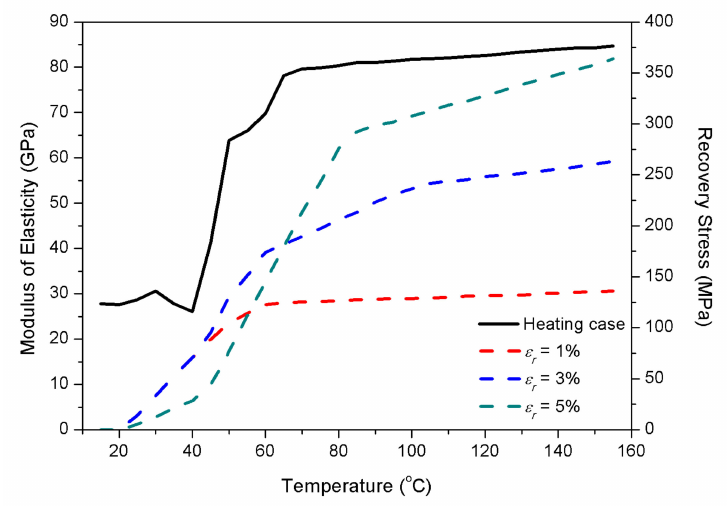
Figure 2. SMA modulus of elasticity and recovery stress vs.